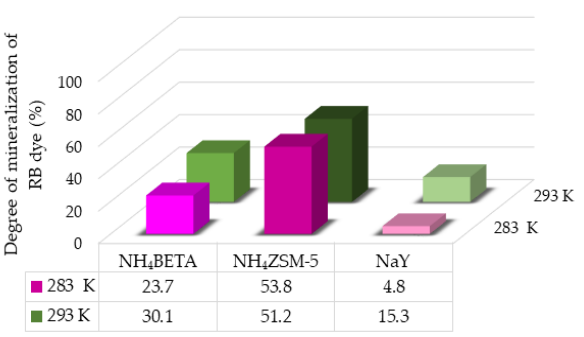
Figure 11. Mineralization degree of RB dye in the presence of selected zeolites after 180 min under UV radiation at two temperatures.